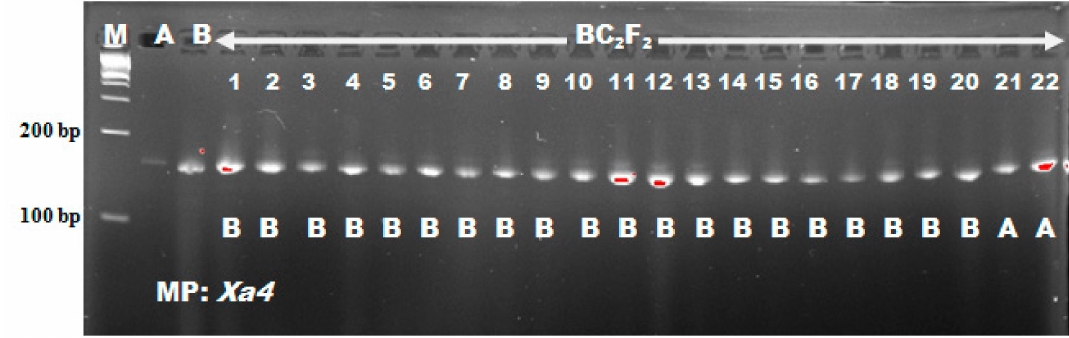
Figure 3. Genotyping and foreground marker-assisted selection of BC 2 F 2 progenies using polymorphic tightly linked markers. Note: Only homozygous “B” allele for Xoo resistance genes were selected at BC 2 F 2. M: 100 bp DNA ladder.